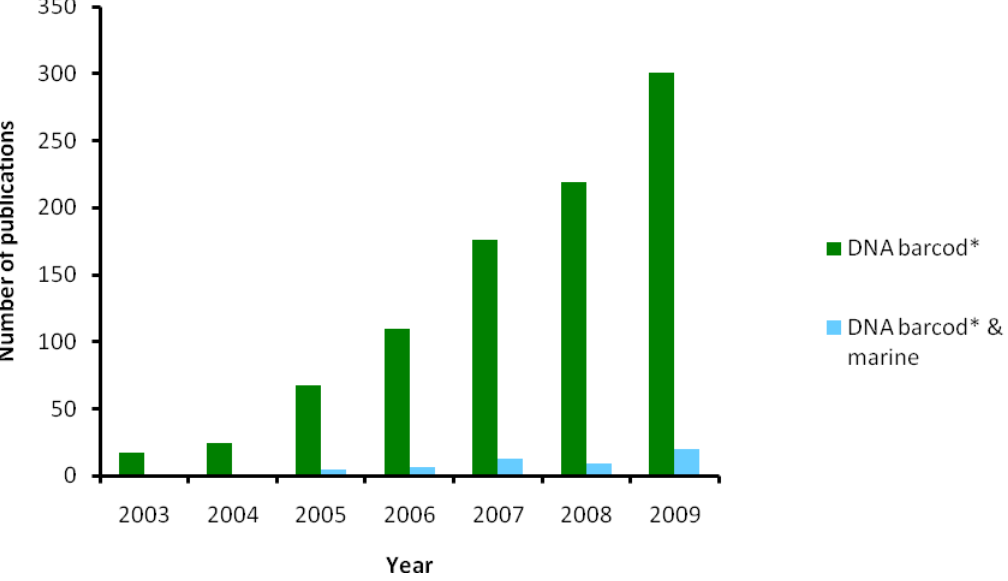
Figure 4. The amount of barcoding studies targeting marine systems (‘DNA barcod*’ and ‘marine’ as keywords in Web of